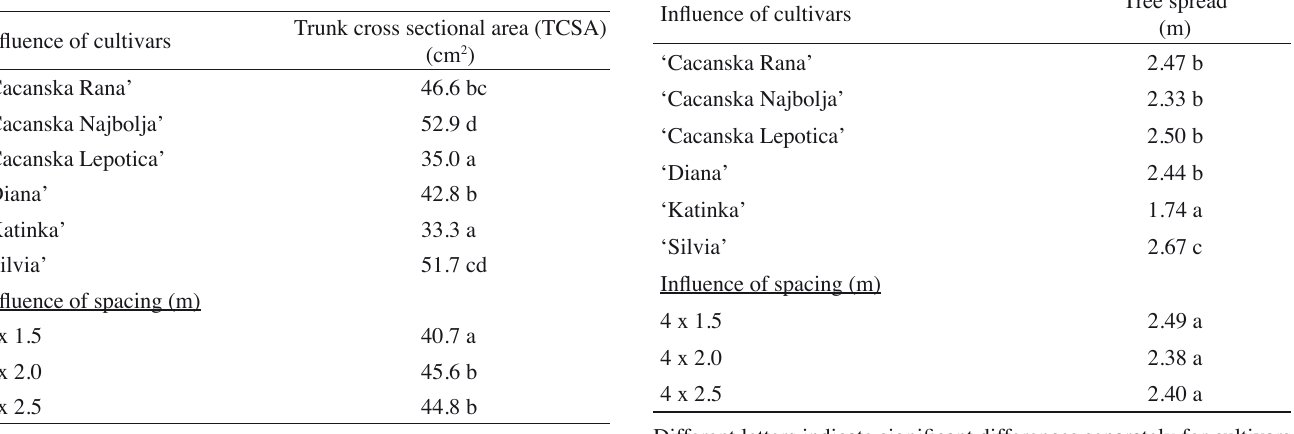
Table 1 - Influence of cultivars and spacing on tree growth expressed by trunk cross sectional area in the sixth year from planting (2010)